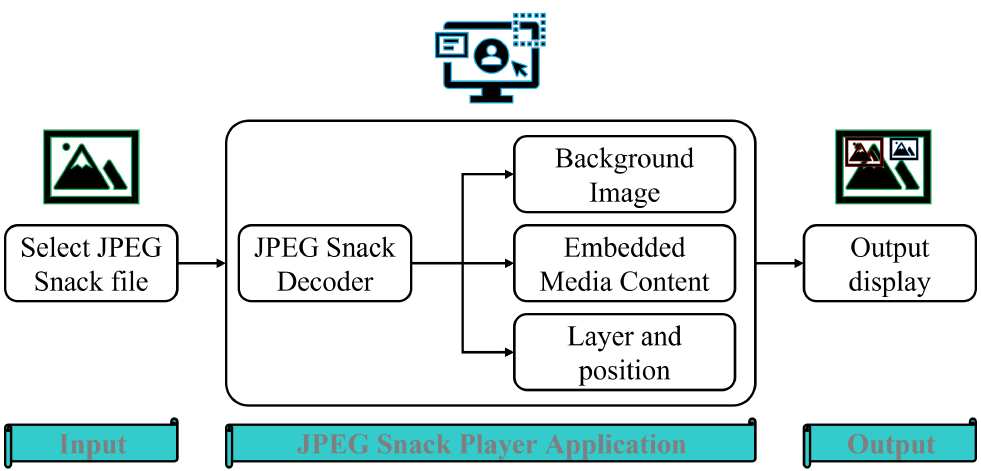
Figure 3. High-level flow diagram of the JPEG Snack